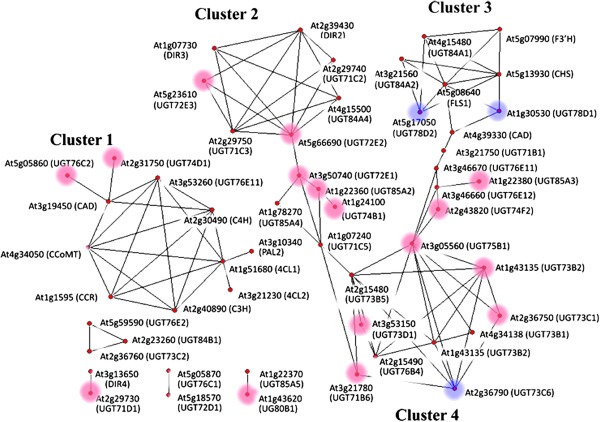
Co-expression correlations of unigenes involved in the flavonoid and lignan biosynthesis. Edges are drawn when the linear correlation coefficient is > 0.5. UGTs with detailed functional description are marked with blue circles; UGTs with functional prediction are marked with red circles.